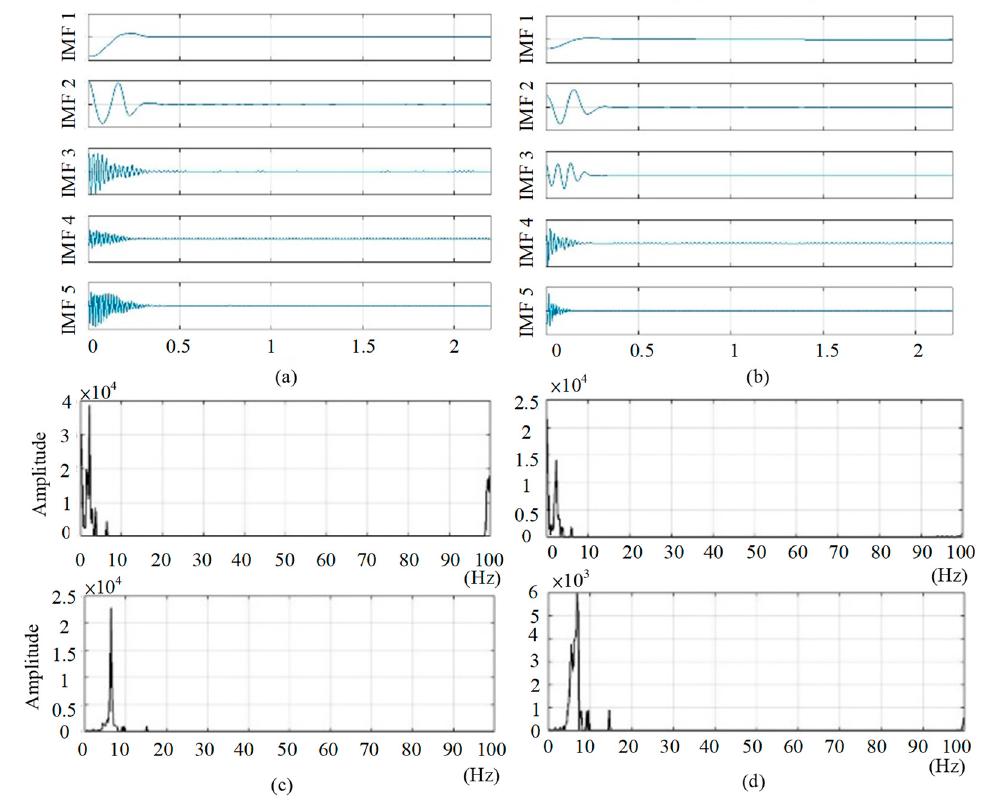
Figure 10. Signals of joint 1. ( a ) VMD of the torque signal. ( b ) VMD of the acceleration signal. ( c ) Acceleration marginal spectrum of IMF 1 and 2. ( d ) Torque marginal spectrum of IMF 1 and 2. Table 5. Vibration characteristics of the VMD-HHT analysis of joint 1.